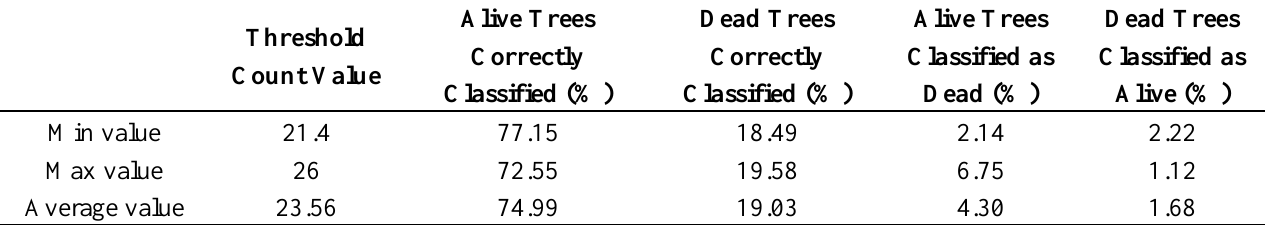
Table 5. Mean percentages of successes classifications and false positives and negatives during the calibration test with a dead range value of 50 at different threshold count values.